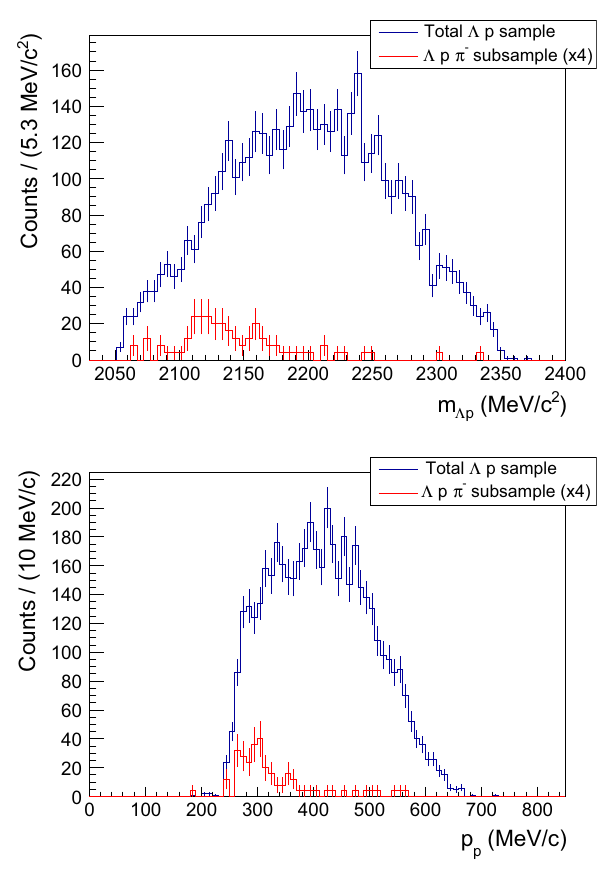
Fig. 3 (cid:2) p invariant mass (top) and proton momentum (bottom) dis- tributions after the selection of the protons from the mass by TOF are shown for the whole (cid:2) p data sample (blue) together with the (cid:2) p π − subsample events (red). The red distribution is multiplied by a factor 4 for a more clear comparison